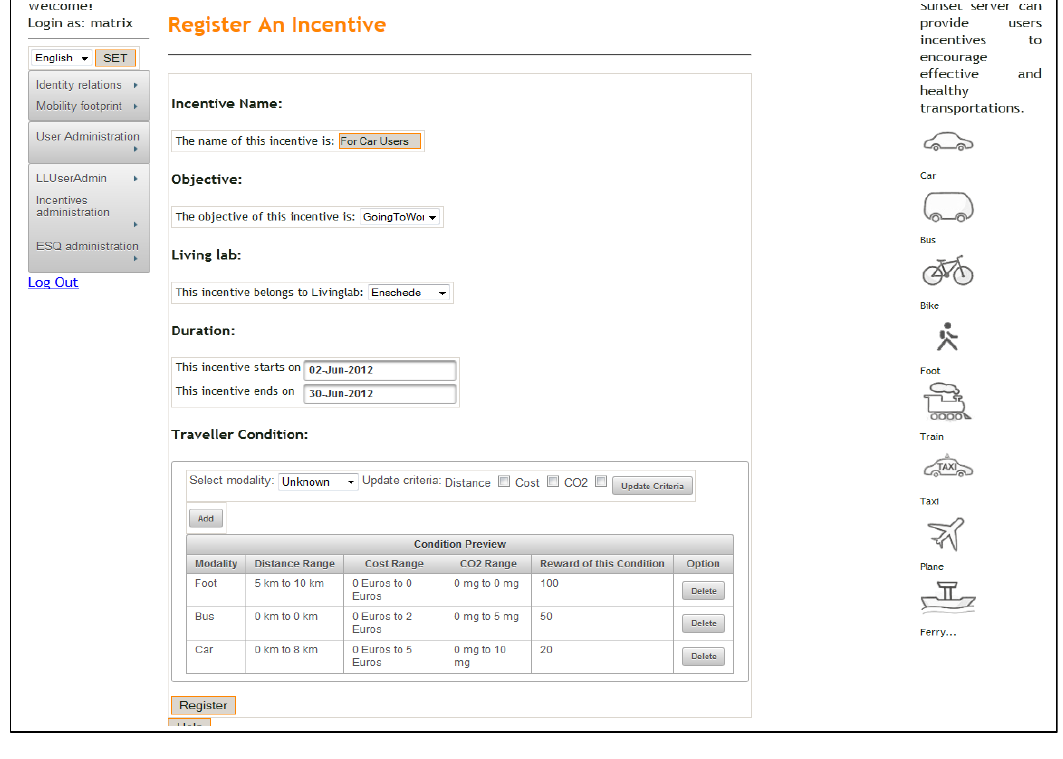
Figure 6. Incentive registration.